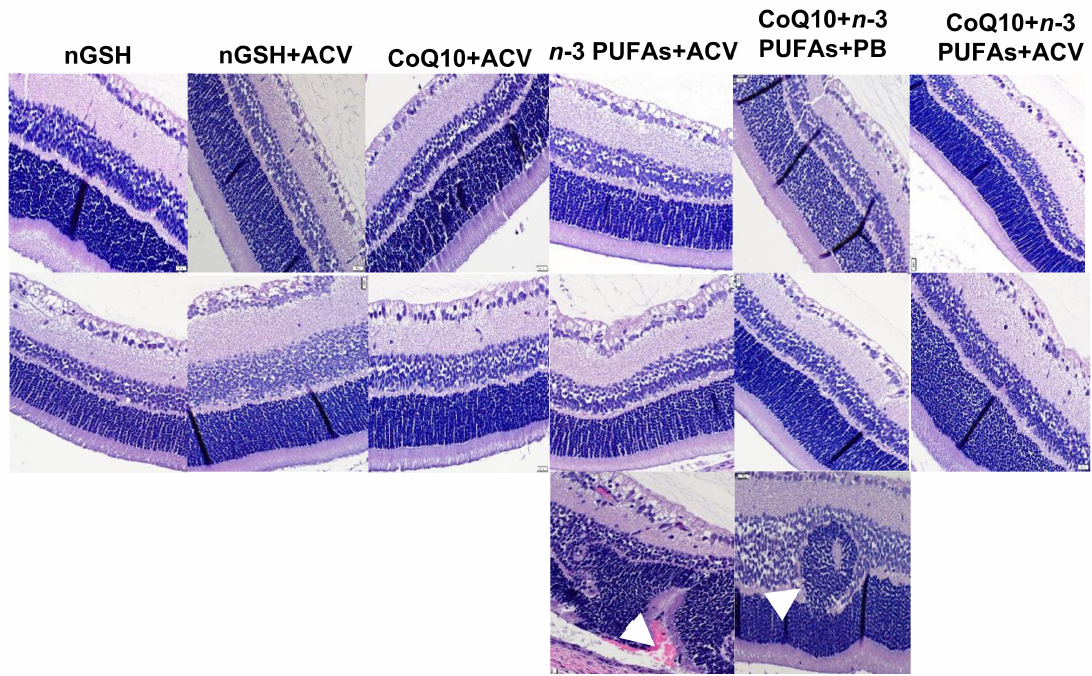
Figure 11. Representative H&E stained retinal layers from neonatal rats on postnatal day 21 (P21). Room air (RA) groups are represented in the top panels and intermittent hypoxia (IH) groups are represented in the bottom panels. Images are 40 × magnification, scale bar is 20 µ